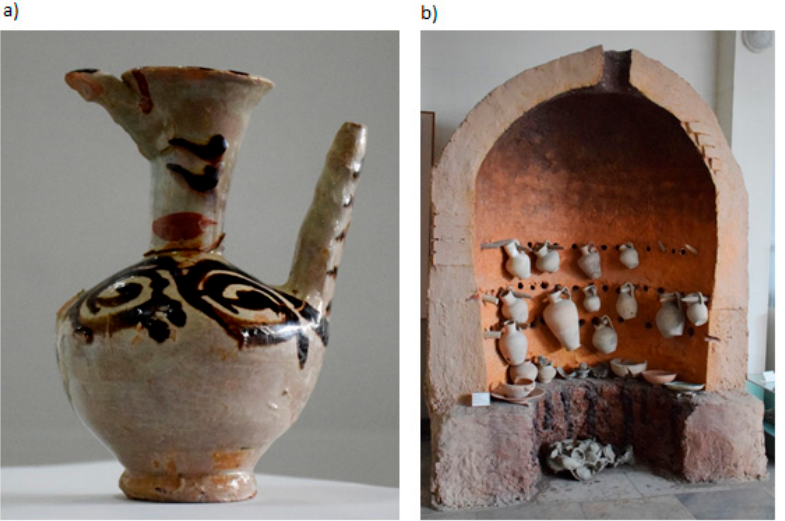
Figure 3. Objects from the Afrasiyab museum: ( a ) 11th/12th century glazed jug, ( b ) reconstruction of the 9th–12th century pottery kiln.